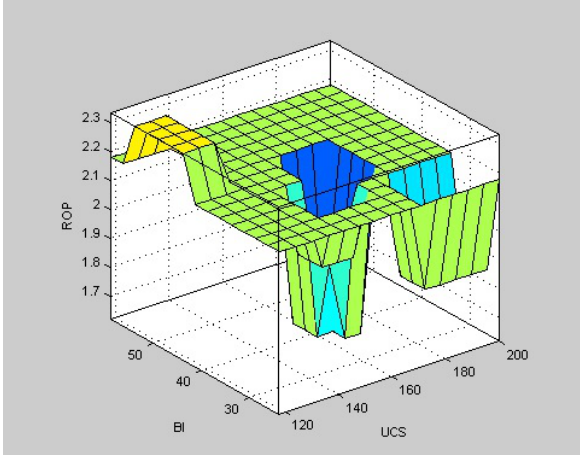
Figure 10: Fuzzy logic surface.